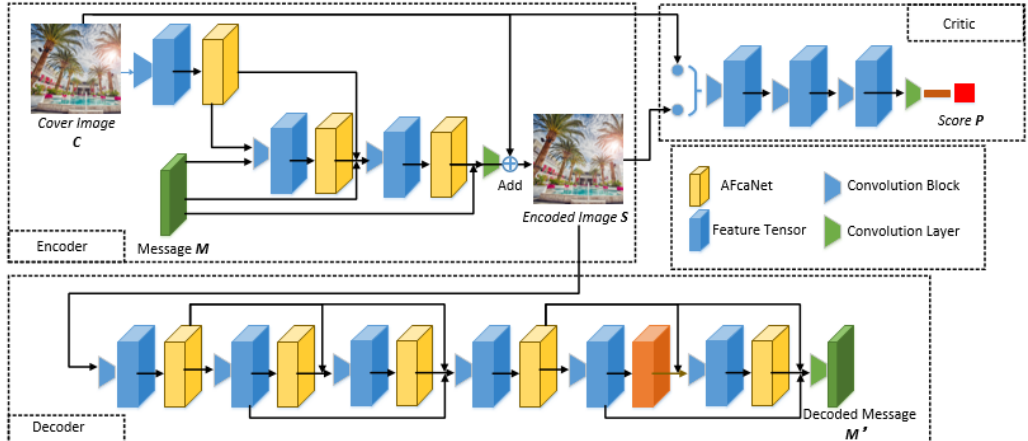
Figure 3. The network structure of